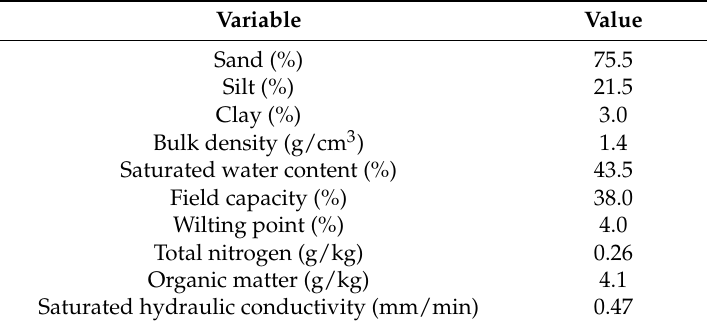
Figure 1. Structure of experimental soil tank. The left side of the soil tank with no vegetation is used in the present study. There are 3 rain gauges, 4 groundwater well and 6 groups of soil moisture (SM) sensors connected to data loggers. Table 1. Soil characteristics in the soil tank.